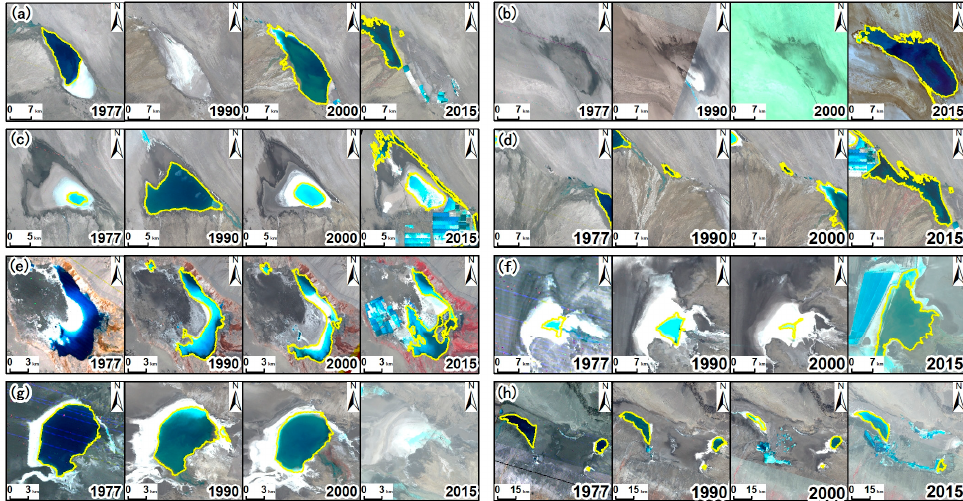
Figure 11. Evolution of typical lakes influenced by human exploitations as shown in Landsat images: ( a ) East Taijinar Lake; ( b ) Yi Ping Li Lake; ( c ) West Taijinar Lake; ( d ) Ya Lake; ( e ) Big Chai Dan Lake; ( f ) South Hodgson Lake; ( g ) North Hodgson Lake; and ( h ) Qarhan Lake area, including Dabsun Lake.